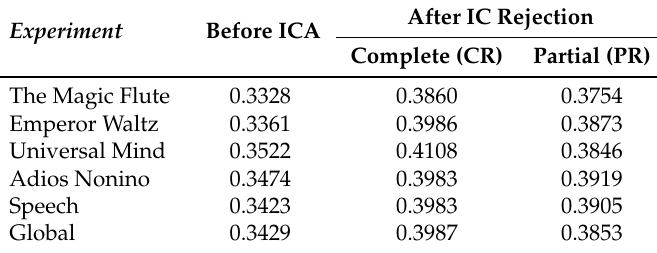
Table 5. SNR before and after CR/PR component removal to diminish the influence of artifacts. Global experiment makes reference to the consideration of all the experiments as a whole for the calculation of